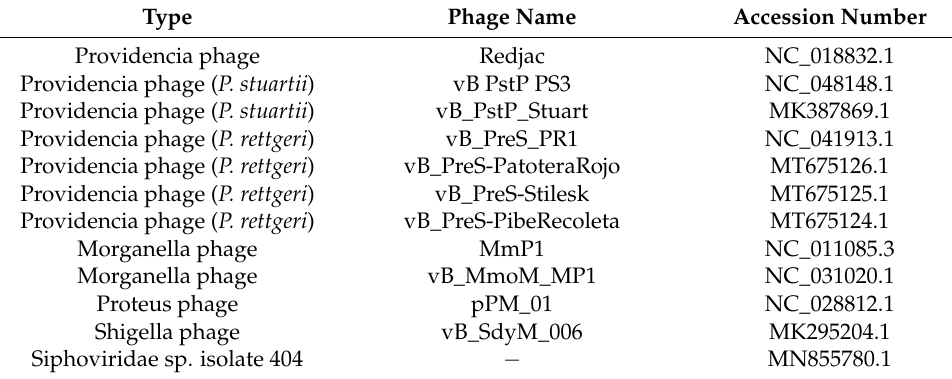
Table 3. Published